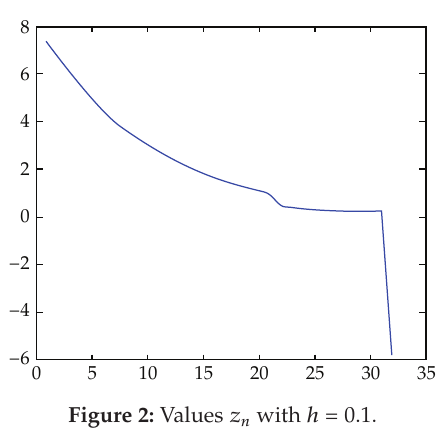
Figure 2: Values z n with h (cid:7) 0 .